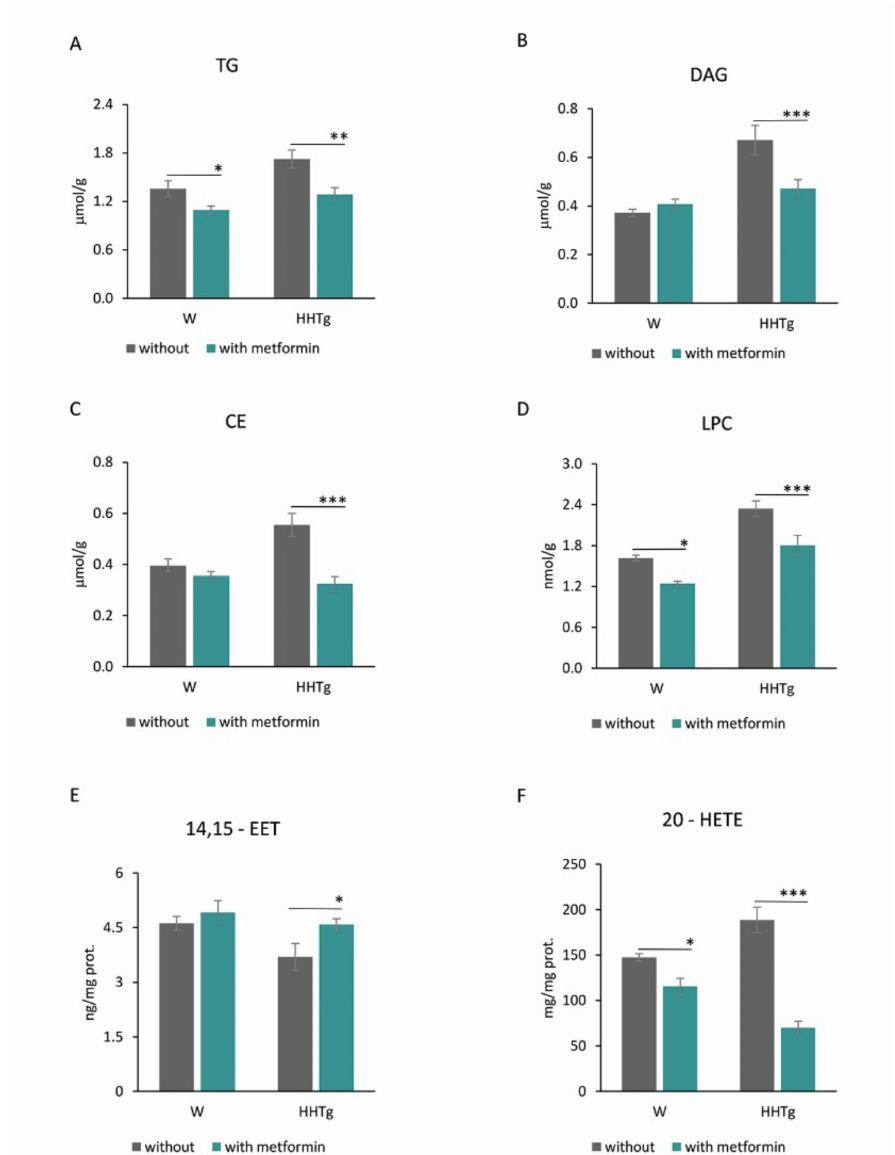
Figure 1. Effects of metformin on myocardial lipids, lipotoxic intermediates ( A ) triglycerides, ( B ) diacylglycerols, ( C ) cholesteryl esters, ( D ) lysophosphatidylcholine) and CYP-derived arachidonic acid metabolites ( E ) 14,15-epoxyeicosatrienoic acid, ( F ) 20-hydroxyeicosatetraenoic acid) in Wistar control (W) and hereditary hypertriglyceridemic (HHTg) rats. Data are mean ± SEM; n = 8 for each group. Significance was determined using two-way ANOVA and Fisher’s LSD post-hoc test (* denotes p < 0.05; ** denotes p < 0.01; *** denotes p <